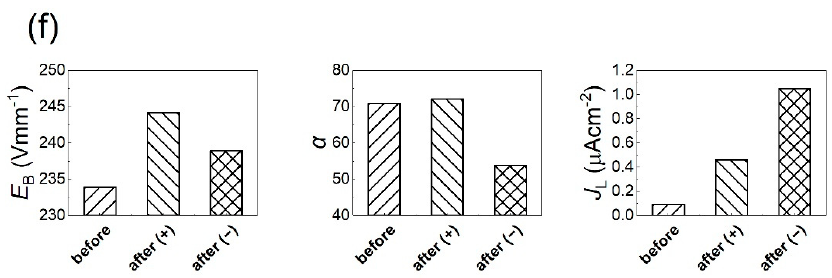
Figure 3. Electrical parameters of S1–S6 before and after DC aging ( a – f ) S1–S6. The nonlinear coefficient α = 1/lg( E B / E A ) was calculated from the current density - electric field ( J - E ) curves, where E A and E B (called breakdown field) are electric fields under 0.1 mAcm − 2 and 1 mAcm − 2 , respectively. The leakage current density ( J L ) was acquired at 0.75 E B .